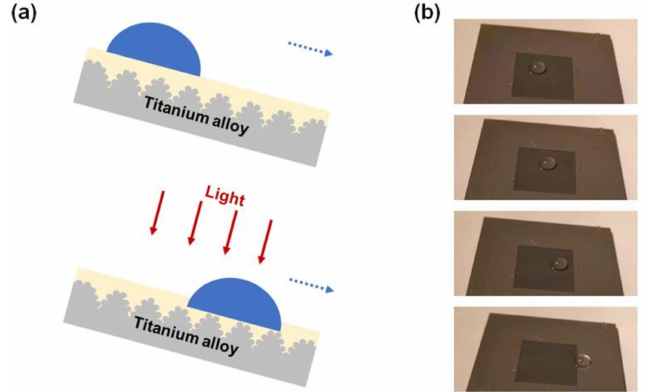
Figure 8. ( a ) Schematic diagram of the droplet sliding on the sample surface after laser processing under light irradiation. ( b ) Droplet sliding on the sample surface under light